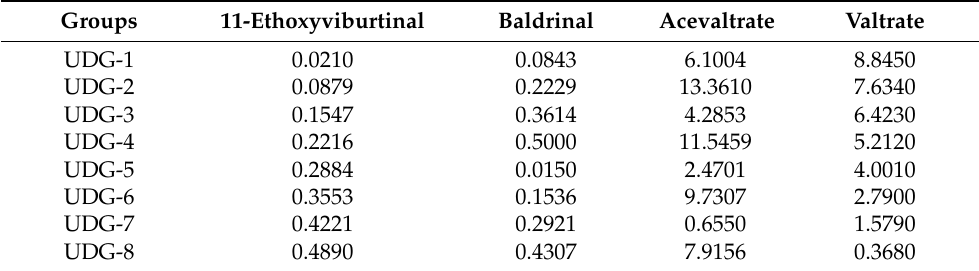
Table 1. Uniform designed group dosing scale